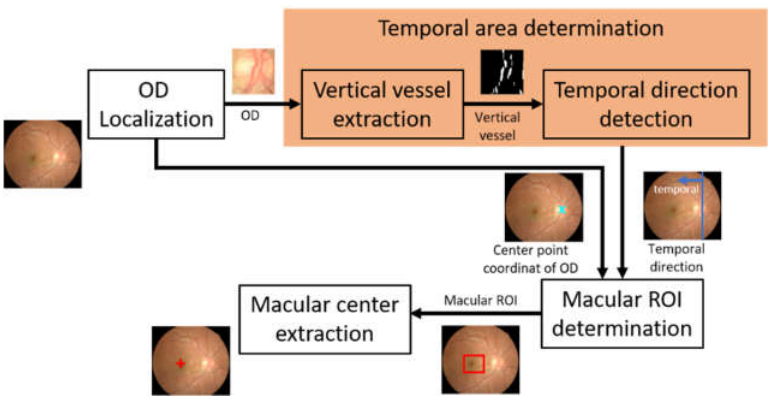
Figure 2. The flow of macular center point detection (OD: optic disc, ROI: region of interest).